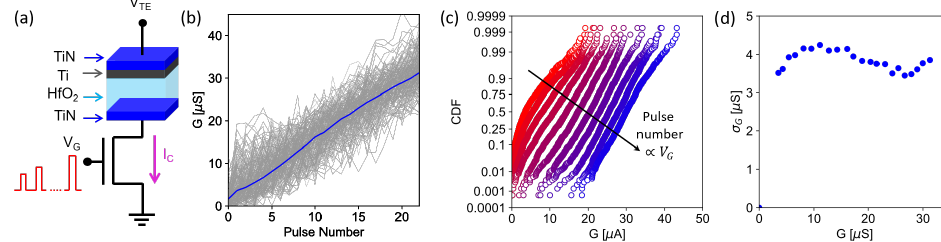
Figure 4. Analog programming with set pulses at increasing I C according to the IGPP algorithm. ( a ) Conceptual schematic of the IGPP algorithm. ( b ) Conductance as a function of pulse number for multiple iterations (grey lines) and the average behavior (blue). ( c ) Cumulative distribution function (CDF) of the conductance for increasing gate voltage V G . ( d ) Standard deviation of the conductance σ G as a function of the average conductance G . Adapted from [51].